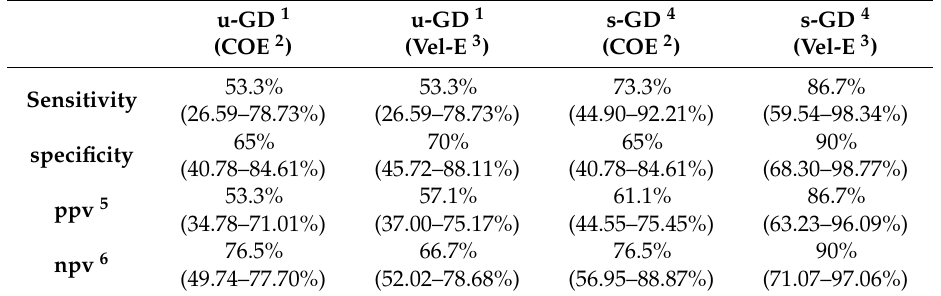
Table 2. Sensibility, specificity, positive predictive value, negative predictive value for the conventional oral examination, and autofluorescence visualization for unskilled-general dentist and skilled-general